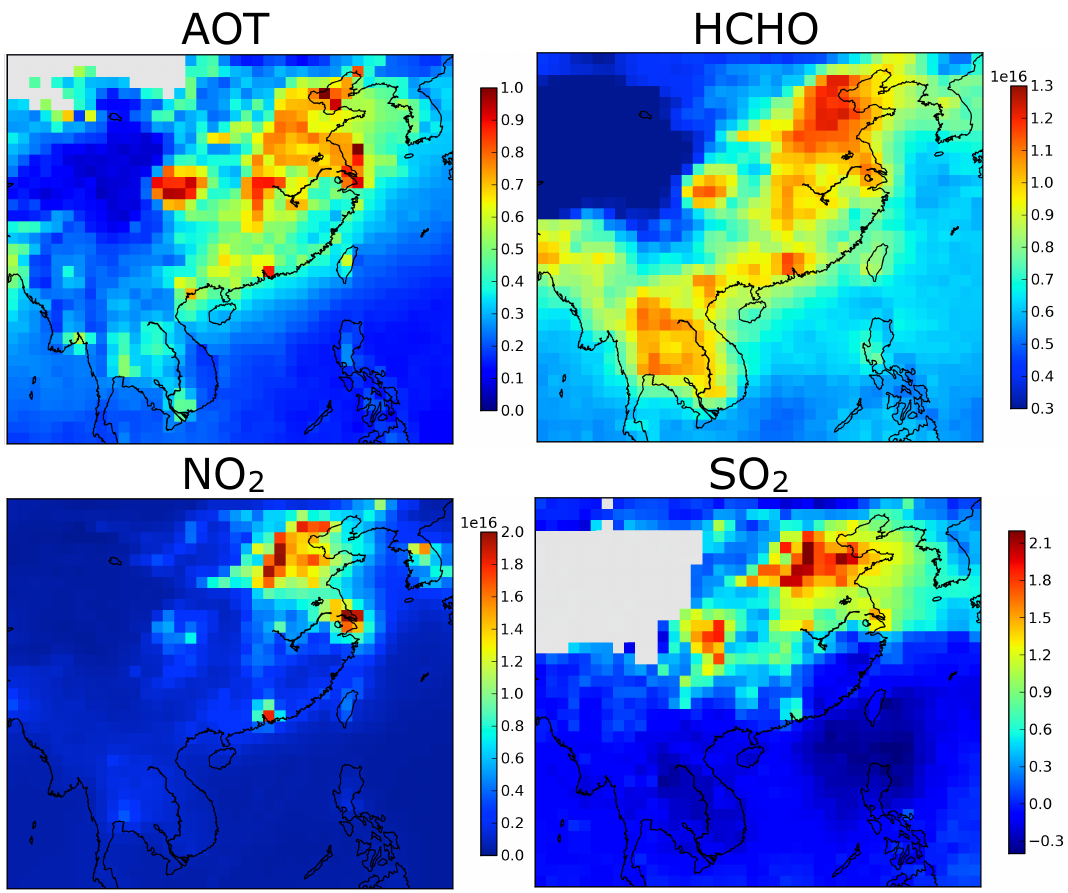
Fig. 5. Maps of mean values for the period 2005–2007 over China of AOT (upper left panel), HCHO in moleculescm − 2 (upper right panel), NO 2 in moleculescm − 2 (lower left panel) and SO 2 in DU (lower right